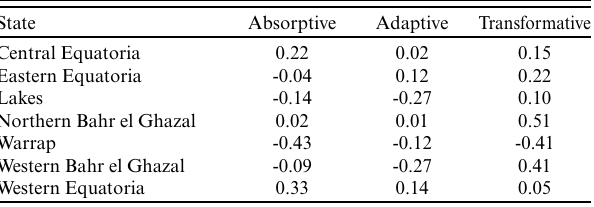
Table 3 . Average z-score values for each category of resilience, as organized at the state level, for the Fortifying Equality and Economic Diversification (FEED) Project dataset, 2015. †